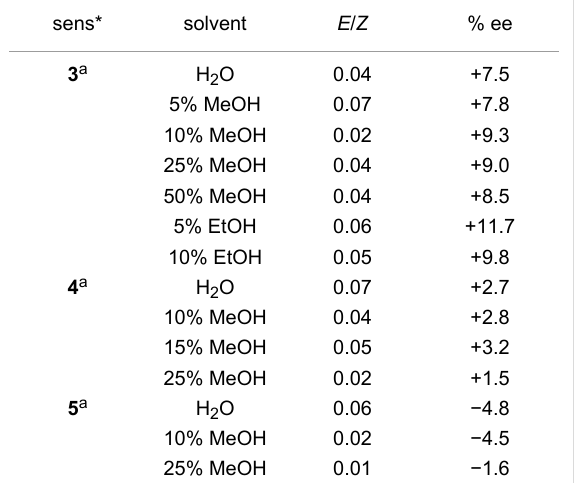
Table 2: Enantiodifferentiating photoisomerization of 1Z sensitized by CDNSs in water containing methanol or ethanol.